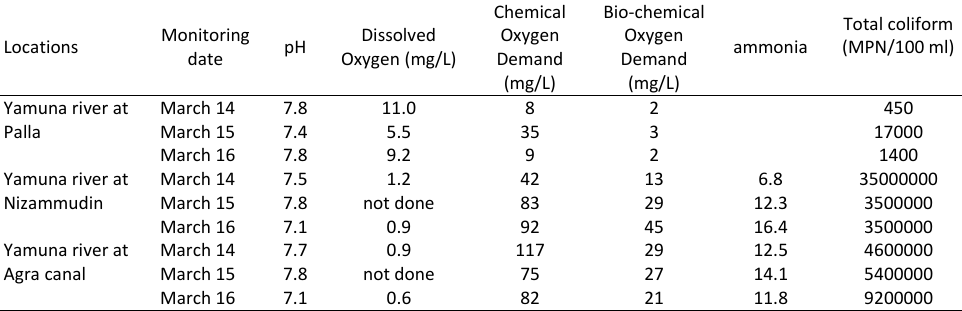
Table1: Comparative figures showing quality of water during March 2014 ‐ 15 ‐ 16 (WQSRY, 2016) Table 4: Water quality parameters with different concentration of eco- enzyme in drain